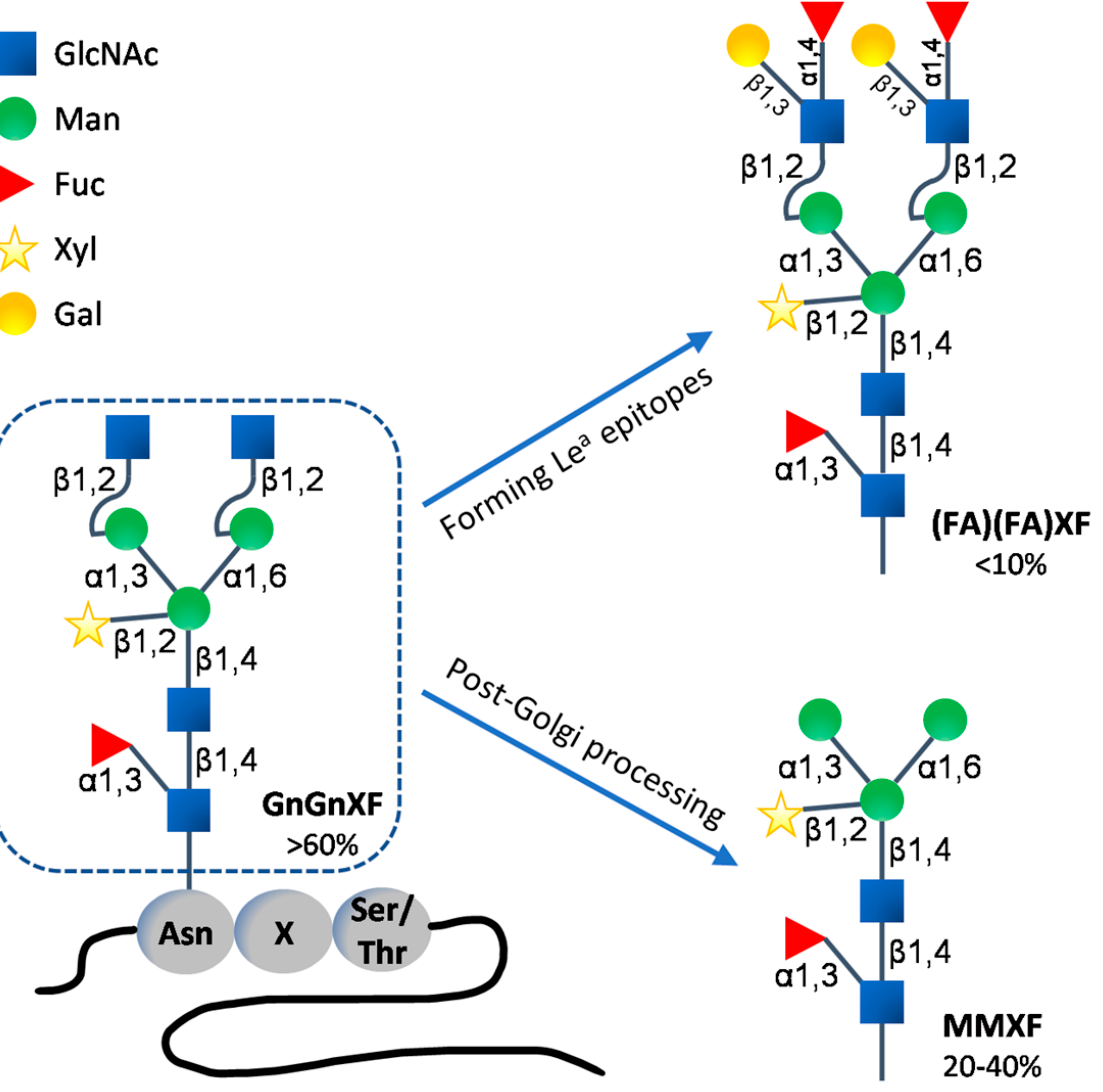
Figure 1. Typical plant-derived N -glycan structures. In plant cells, the GnGnXF structure accounts for the majority of the N -glycoforms. The second most abundant structure is the paucimannosidic